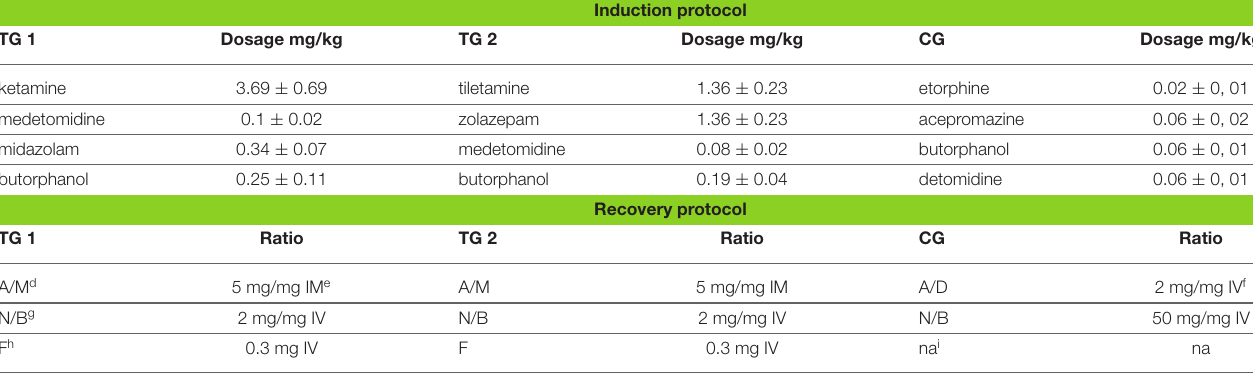
TABLE 1 | Drug dosages for induction and reversal of immobilization, in TG a 1: ketamine–medetomidine–midazolam–butorphanol (KMMB), TG 2: tiletamine–zolazepam–medetomidine–butorphanol and CG b : etorphine–acepromazine–detomidine–butorphanol (EADB) immobilized kulans (Equus hemionus kulan). Induction protocol